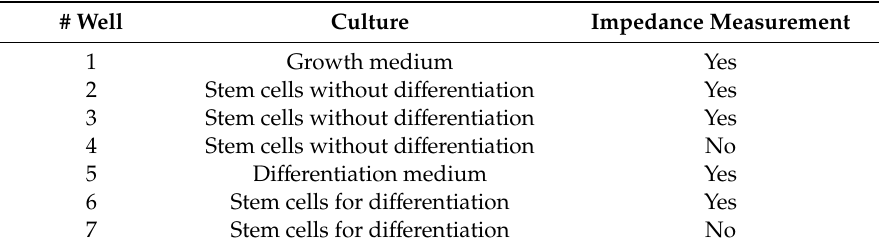
Table 1. Wells used in the 8W10E PET